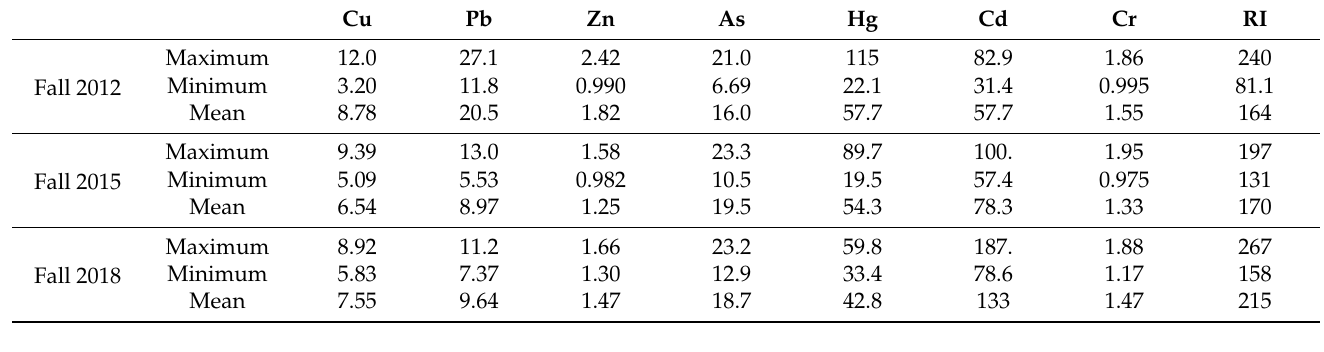
Table 4. Statistical results of the potential ecological risk index evaluation.